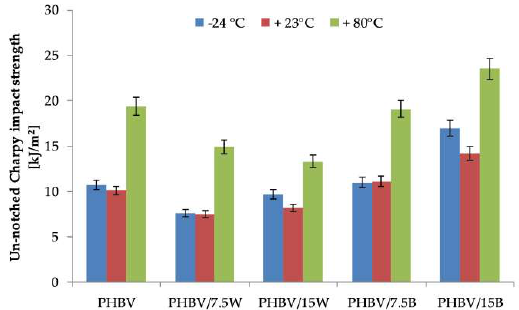
Figure 2. Un-notched Charpy impact strength of PHBV and its composites at −24, 23 and 80